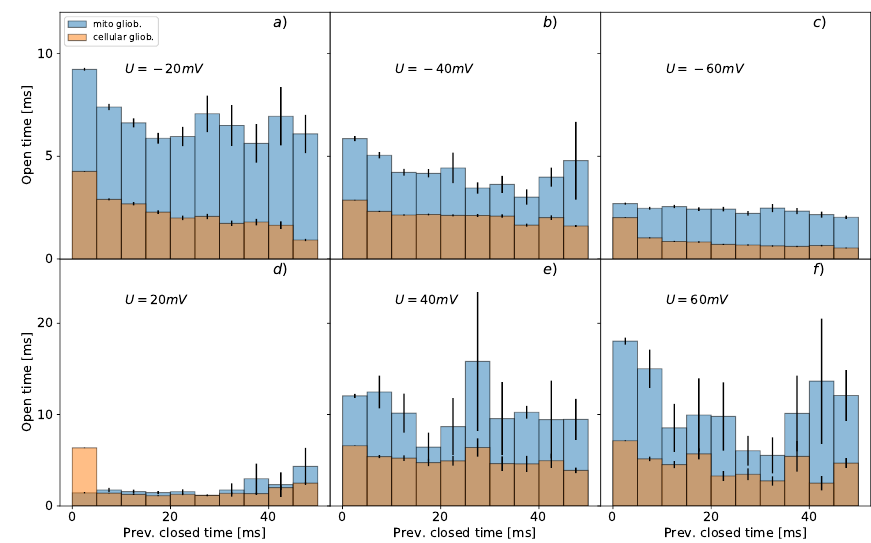
Figure 2. Mean conditional dwell-times of open states with error bars representing the corresponding standard deviations. The blue bars characterize the average values of conditional mean dwell-times for mitochondrial channels; the orange bars are assigned to the data describing BK channels from the plasma membrane. The upper panels ( a – c ) present the results obtained at membrane hyperpolarization; the lower graphs ( d – f ) correspond to channel characteristics at membrane depolarization.